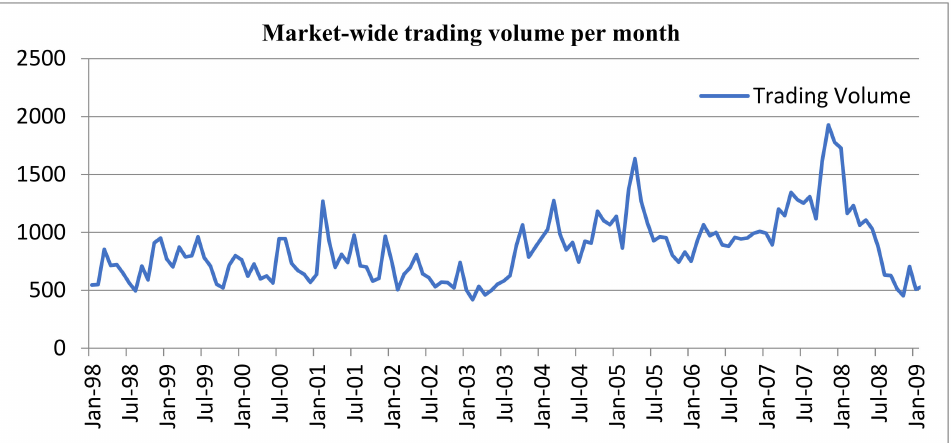
Figure 1. Liquidity of the Hong Kong Island housing market, 1998–2009. Source: authors’ own calculation based on the